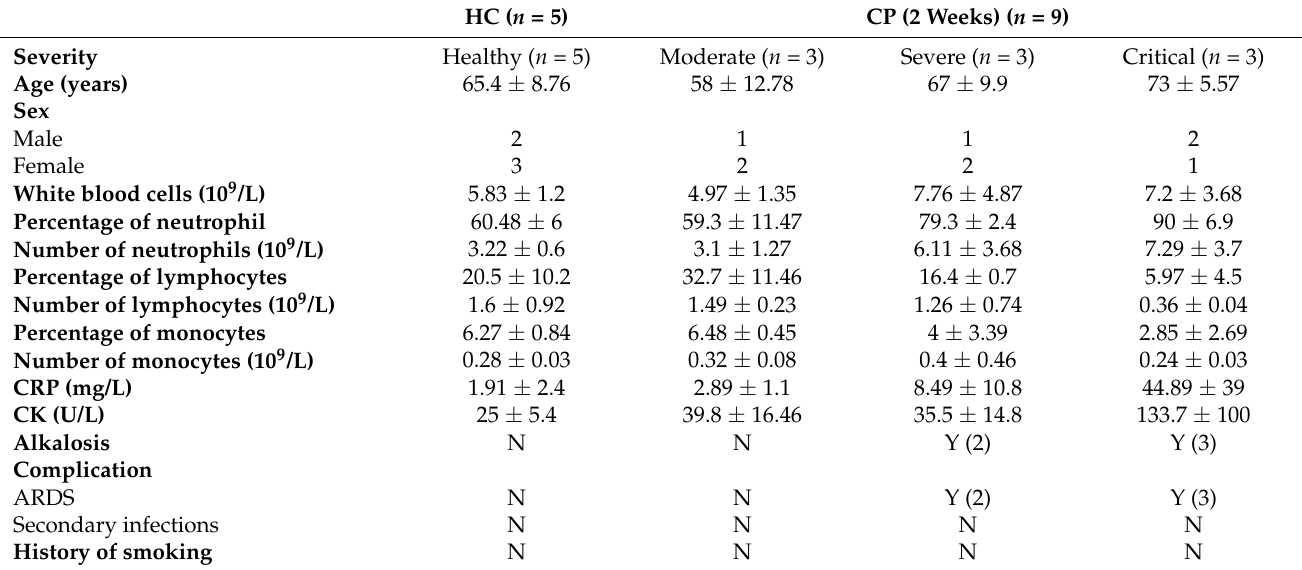
Table 1. Clinicopathologic characteristics of the study population. HC ( n =